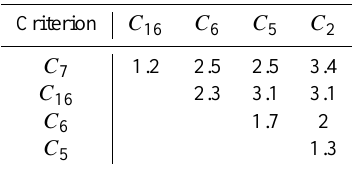
Table 10. Pairwise comparisons matrix of the criterion importance to complete the goal of “offering optimal combating-desertification